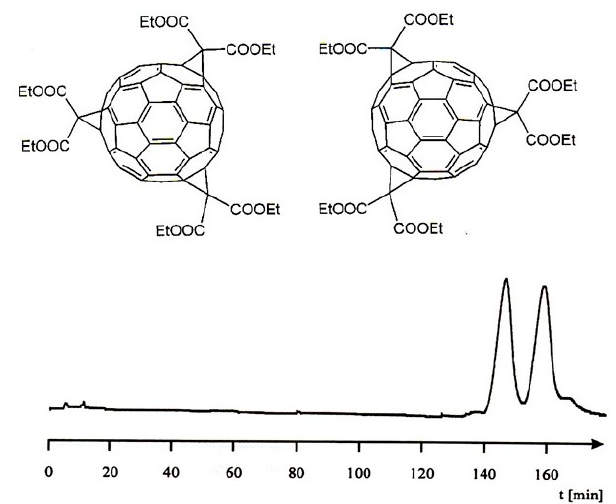
Figure 20. Top : Structure of the tris -adduct C 60 [C(COOEt) 2 ] 3 . Bottom : Enantioseparation of a hexakis -adduct C 60 [C(COOEt) 2 ] 6 on the CSP TAPA bonded to aminopropyl silica gel by micro HPLC ( α = 1.1). Packed fused-silica capillary (20 cm × 0.25 mm I.D.), μ L/min acetonitrile/water (75/25, v/v ), room temperature. Reprinted with permission from [85].